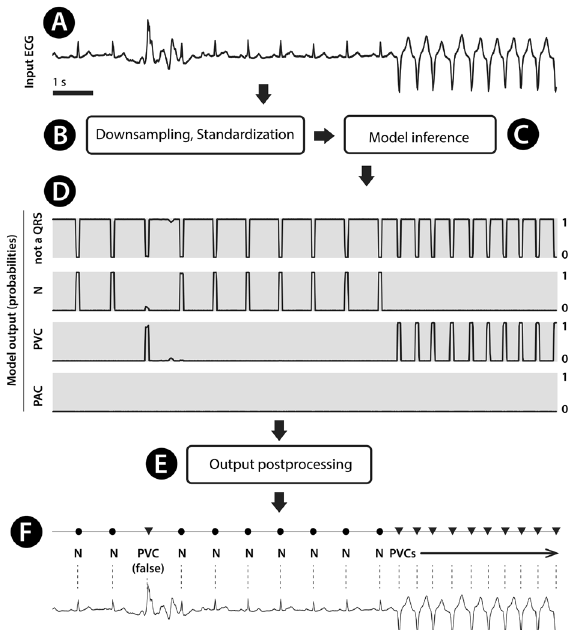
Figure 4. A workflow to detect and classify QRS with the proposed method. The ECG signal ( A ) is preprocessed ( B ) and imputted to the inference engine with the deep-learning model ( C ). The output of the model ( D ) consists of four probability vectors at the length of the input ECG signal. Output vectors are post- processed ( E ), and QRS annotation marks and classes are reported ( F ). N refers to normal sinus beat; PVC refers to premature ventricular contraction with one example of correctly detected but incorrectly classified QRS (the left-most